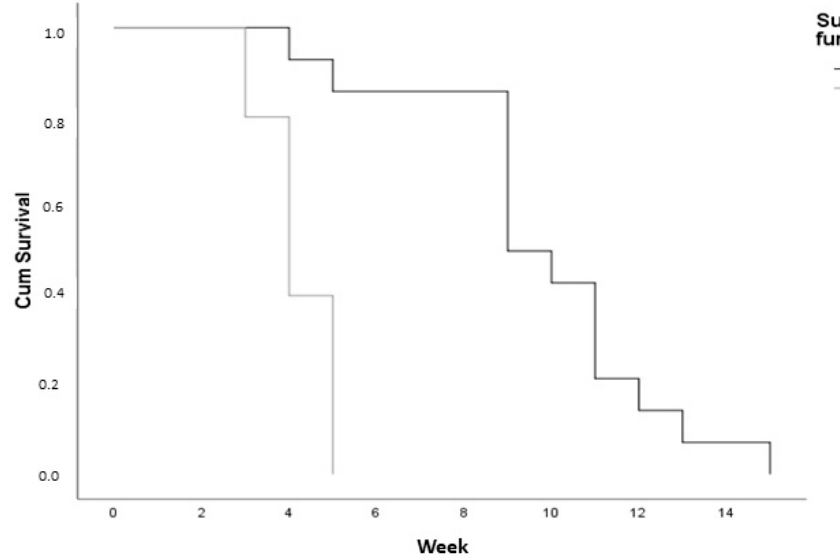
Figure 2. Survival function of starved and unstarved males of L. africanus . (Kaplan–Meier analysis, p = 0.00).